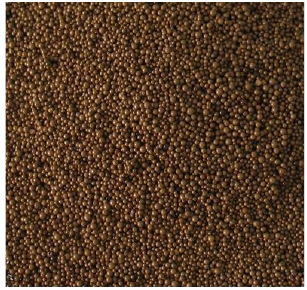
Figure 1. Purolite MN 202.